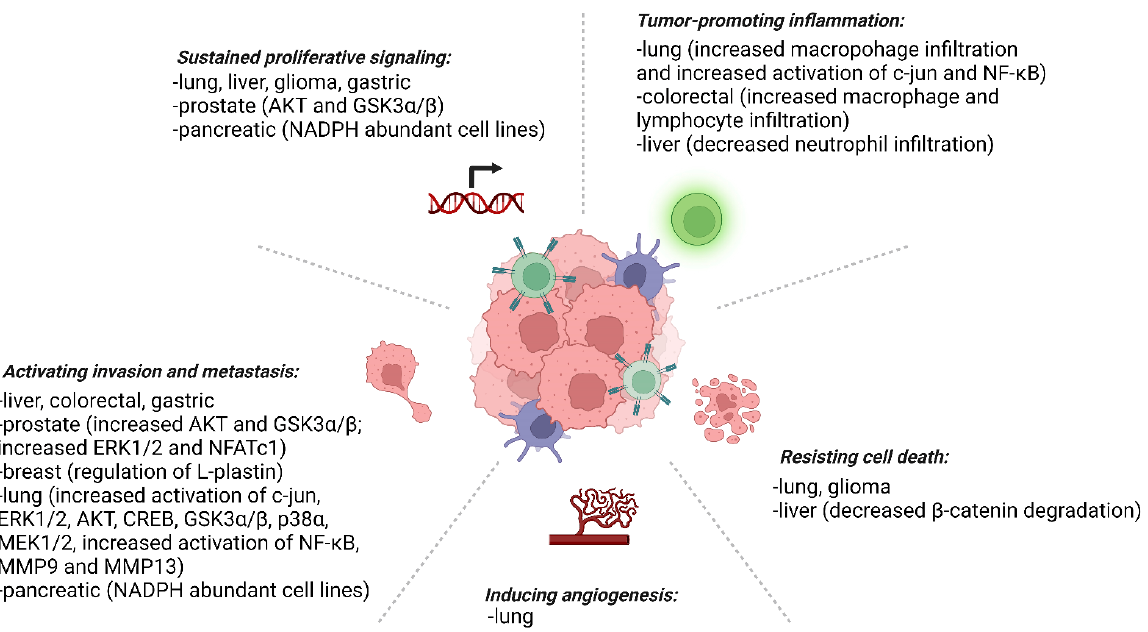
Figure 5. Prx4 promotes the hallmarks of cancer in different cancer types. Known aberrant signaling pathways and markers are shown in parentheses.